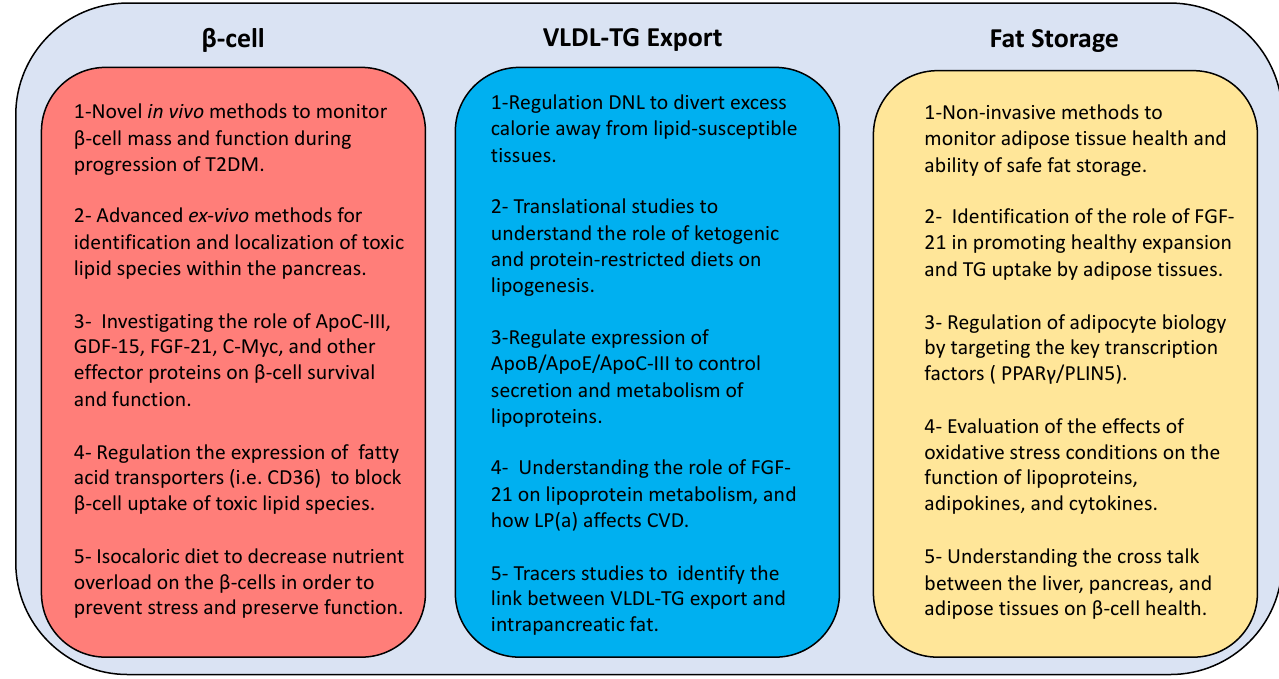
Figure 4. New directions of research for developing novel therapies to manage type 2 diabetes. T2DM: type 2 diabetes mellitus; GDF-15: growth differentiation factor 15; FGF-21: fibroblast growth factor 21; C-myc: cellular myelocytomatosis oncogene; β-cell: beta cell; CD36: cluster differentiation 36; DNL: de novo lipogenesis; ApoB: apolipoprotein B; ApoE: apolipoprotein E; ApoC-III: apolipoprotein C-III; LP(a): lipoprotein (a); VLDL-TG: very low density lipoprotein triglyceride; PPARγ: peroxisome proliferator-activated receptor-γ; PLIN5: perilipin 5.